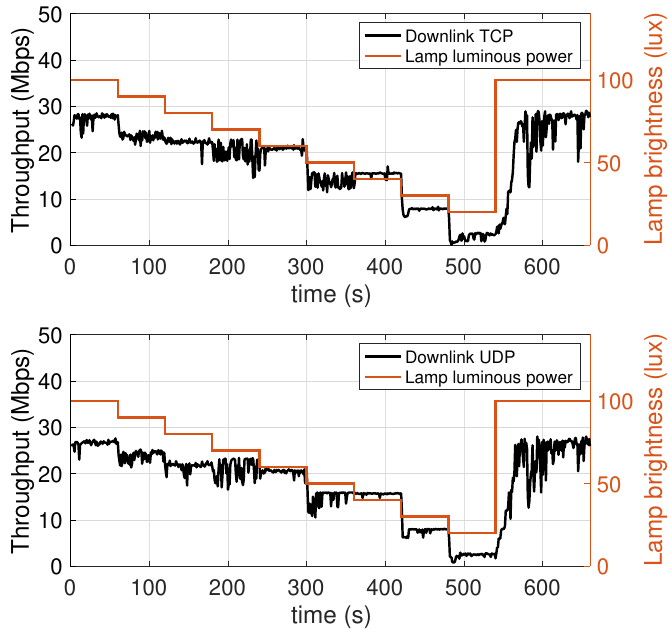
Figure 9. Downlink throughput with different lamp luminous power values. TCP (top chart) and UDP (bottom chart).